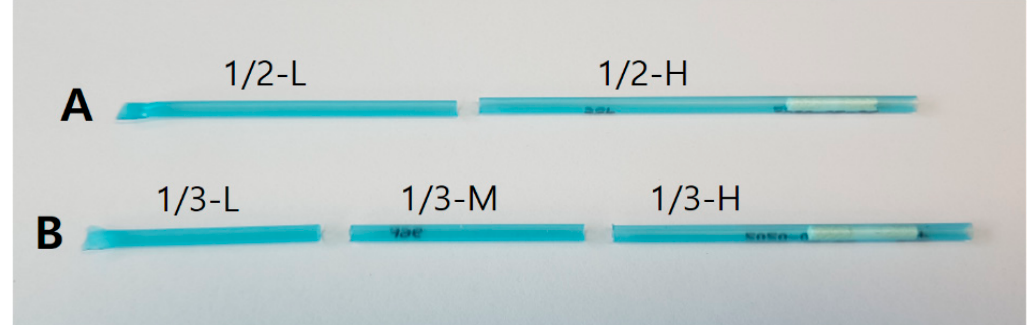
Figure 1. Images of the samples after applying the cutting treatment to hollow 0.5 mL straws. The hollow straw ( A ) is divided into two cuttings, each with one opening;1 / 2-H is a cutting from the top portion with a cotton seal, and 1 / 2-L is a cutting from the lower portion with a sealed end. The hollow straw ( B ) is cut twice, producingthree cuttings; 1 / 3-M is the middle portion of the straw with two